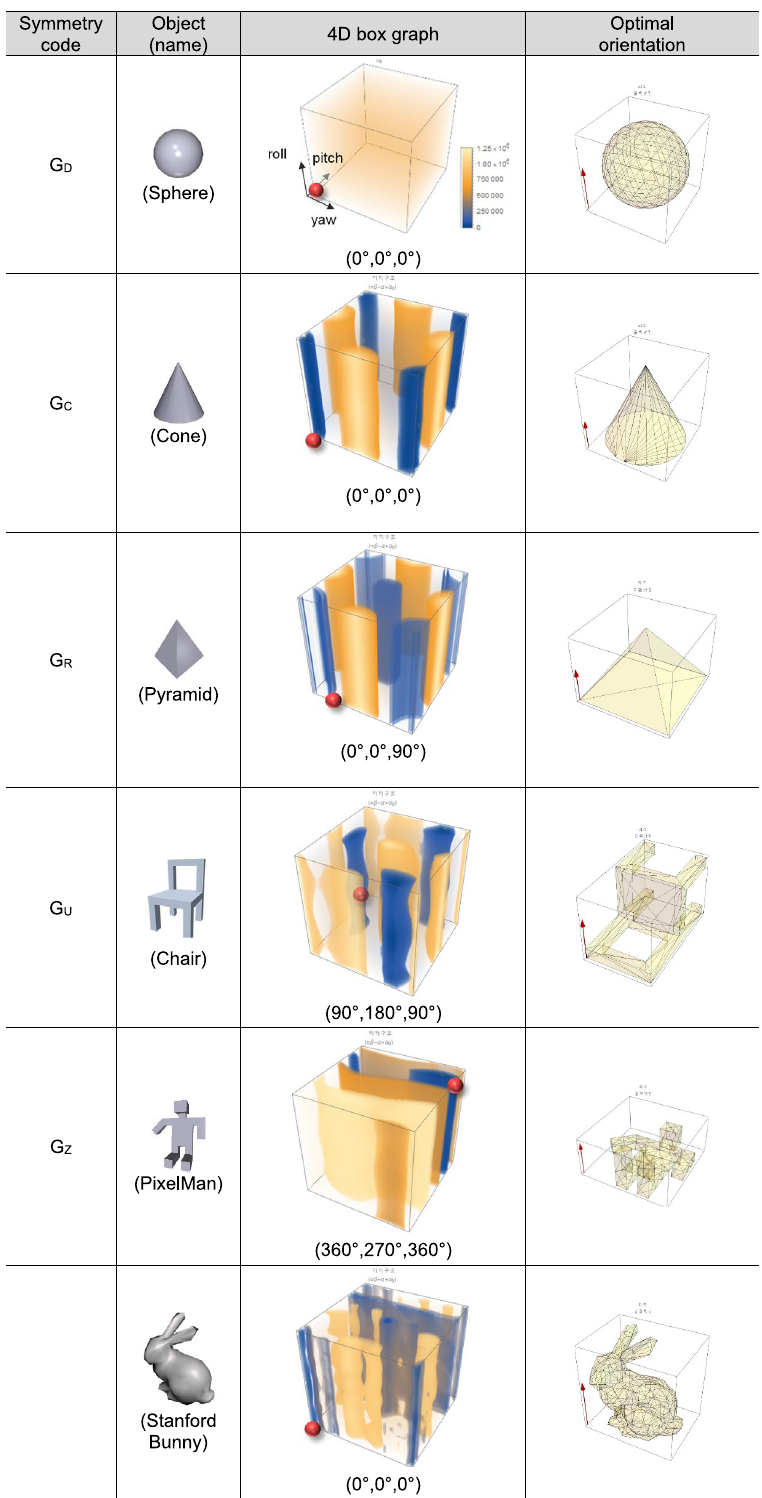
Fig. 4 4D box graph representation of support structure amount for each shape symmetry (blue color means the lowest amount of support structure volume. Angle interval